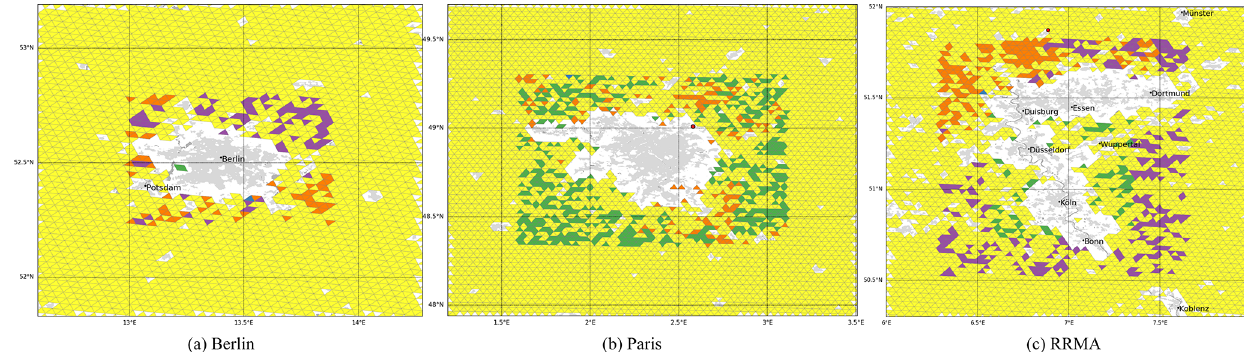
Figure 1. Color-coded grid point selection for all 7 methods for Berlin, Paris and the Rhine-Ruhr Metropolitan Area (a–c) . Triangles represent the model grid-point, while the red circle is the station used. The GlobCover original 1km resolution urban land use data is shown in light-grey shading as reference. Table 1. Case study baseline values (in Celsius) for UHI calculation. Values for M7 have been averaged on the M4 area as comparison. Region M1 M2